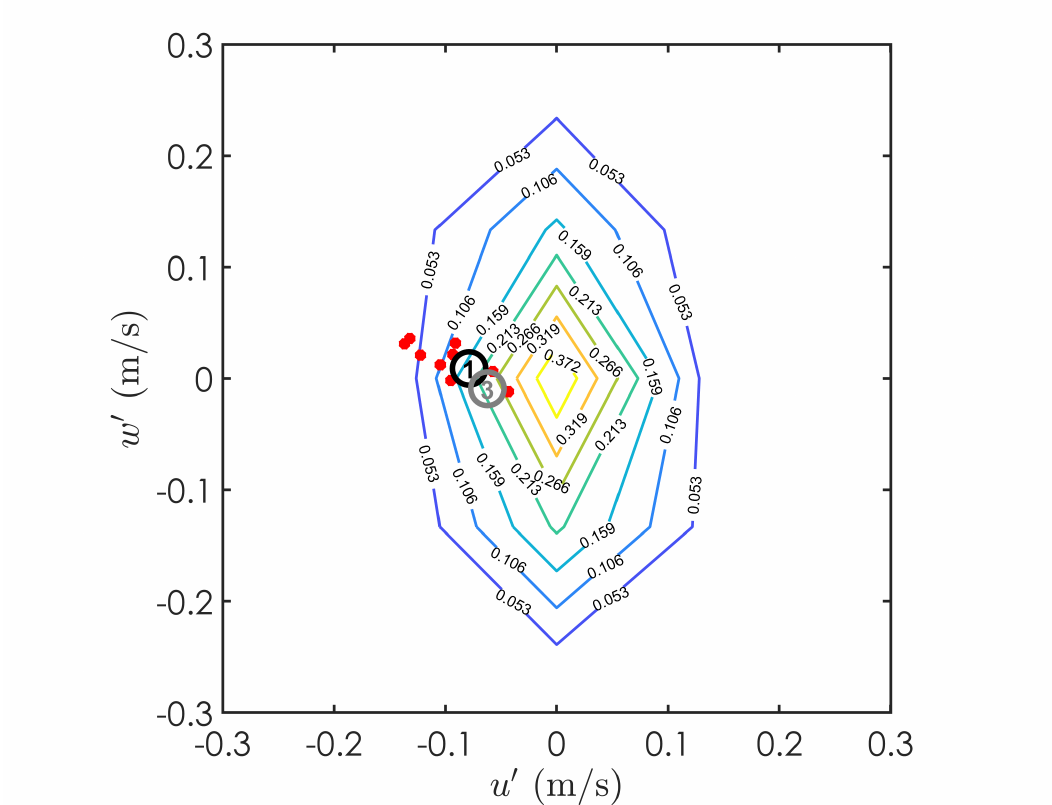
Figure 20. Instantaneous velocity fluctuations characterizing test T1—Approach B. Red dots represent the turbulent flow field associated with deposited particles. Disentrainment events discussed later are marked with numbered open circles: particle 1 (black) and particle 3